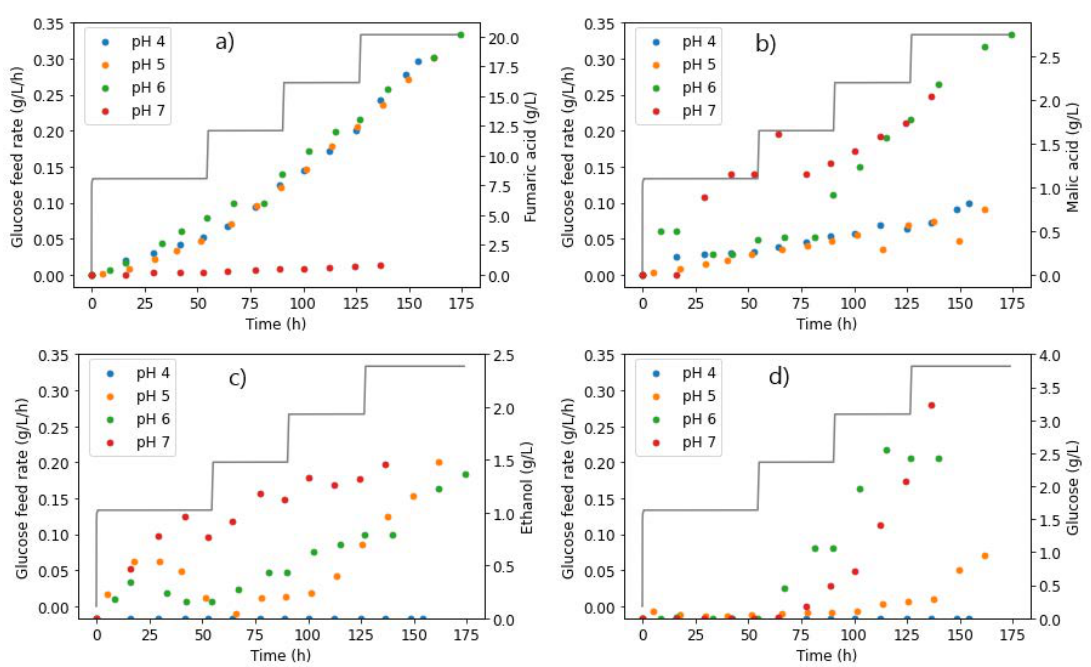
Figure 7. Glucose feed rates and extracellular concentrations of ( a ) fumaric acid, ( b ) malic acid, ( c ) ethanol, and ( d ) glucose, taken from the reactor during fermentation with R. delemar at different pH